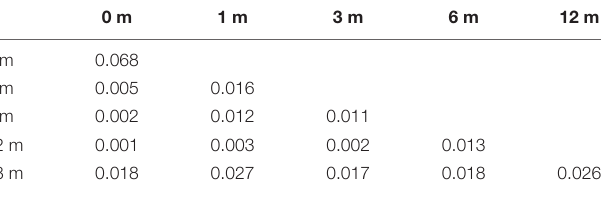
TABLE 3 | Comparison of the categories of auditory performance (CAP) scores for each time point in the common cavity deformity (CCD) group. 0 m